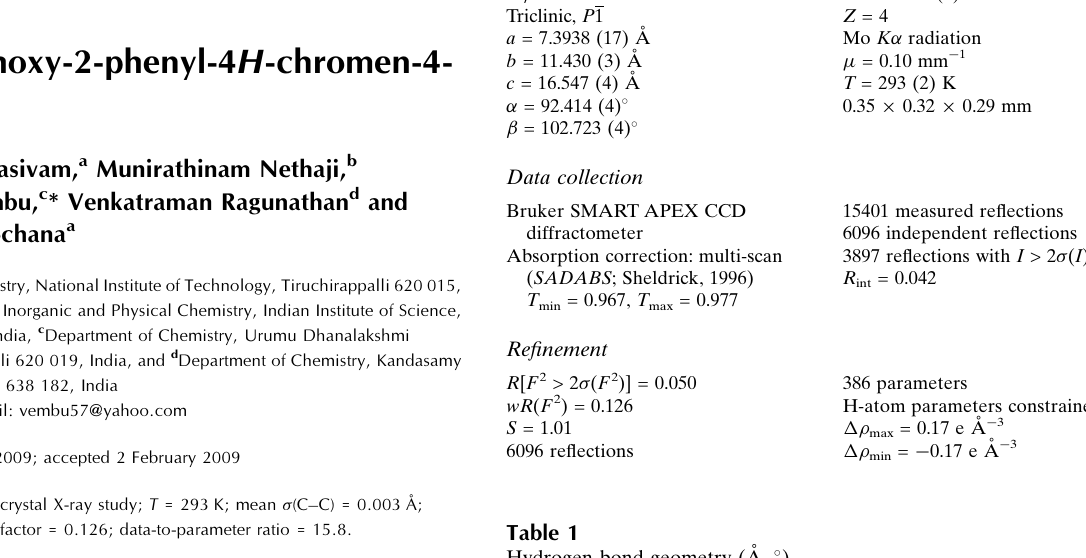
Hydrogen-bond geometry (A˚ , (cid:1) ).